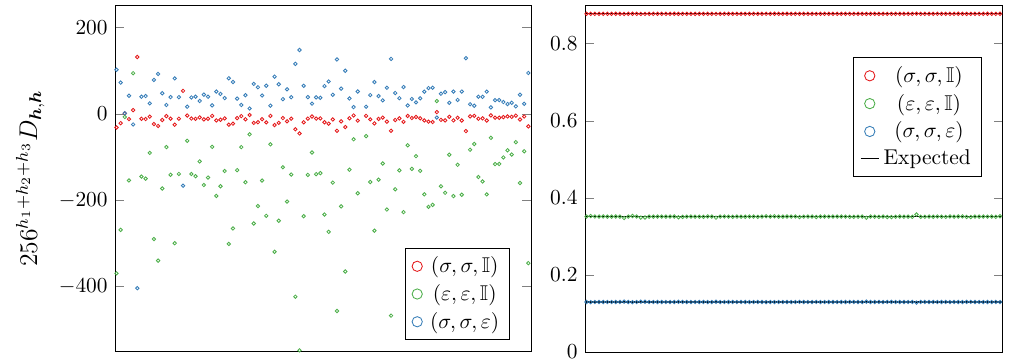
Figure 5 . We plot the values obtained for the N = 3 structure constants D h , h (rescaled by a factor for representation purposes) in the Ising CFT by solving the cross-symmetry eq. (5.26) for 100 different sets of random points, choosing κ = 0 . 22 , and considering two different approximations for the orbifold conformal blocks. On the left, we have taken the small z expansion derived for them in eq. (3.29), truncated at order L = 6 . On the right, we have expanded them in sphere conformal blocks, as in eq. (4.5), until L = 6 and we have applied the elliptic recursion of eq. (4.6) to compute the latter up to level L 0 = 6 . The solid lines correspond to the values expected for the structure